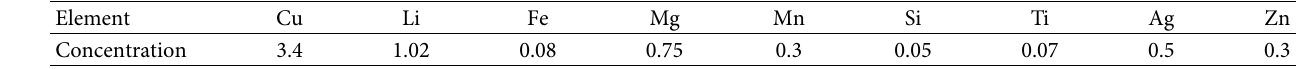
Table 1: Chemical composition of BM AA2198-T8 (wt%).